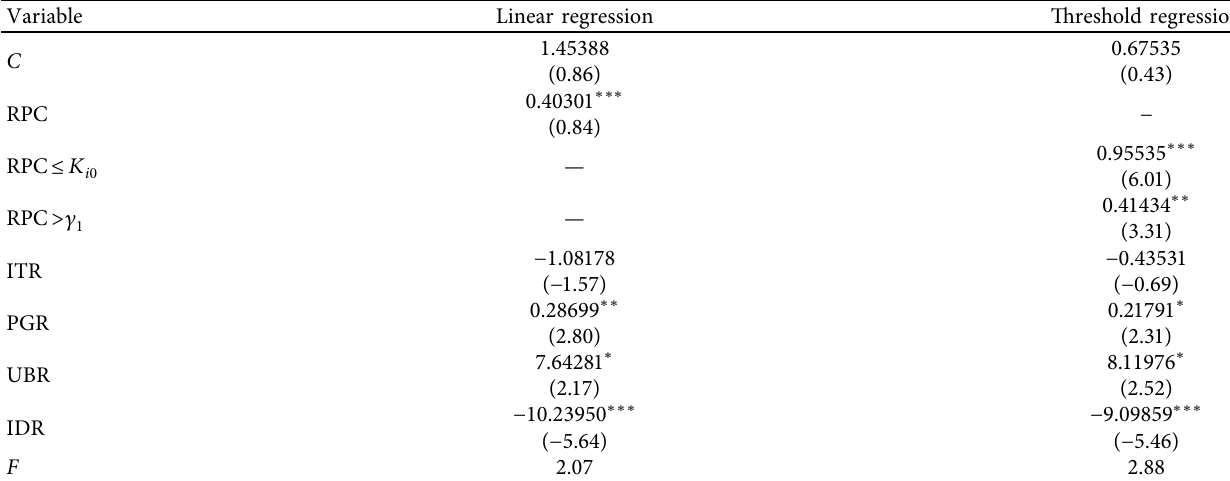
Table 9: Parameter estimation results with infrastructure as threshold